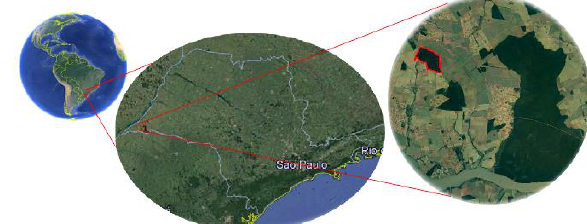
Figure 2. Location of the study area. Ponte Branca is highlighted in red in the right part of the